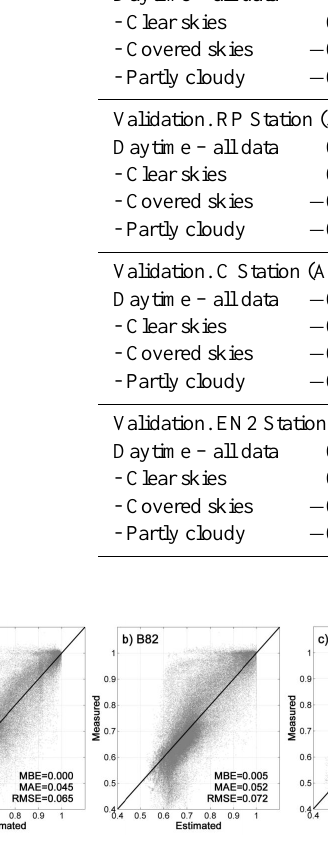
Fig. 7. Atmospheric emissivity measurements versus estimation obtained for the Fig. 6. Atmospheric emissivity measurements versus estimation ob- simulation at C Station (1332 m a.s.l.) using the three different schemes locally tained for the calibration at RP Station (2500ma.s.l.) using the three calibrated with RP data. different schemes.